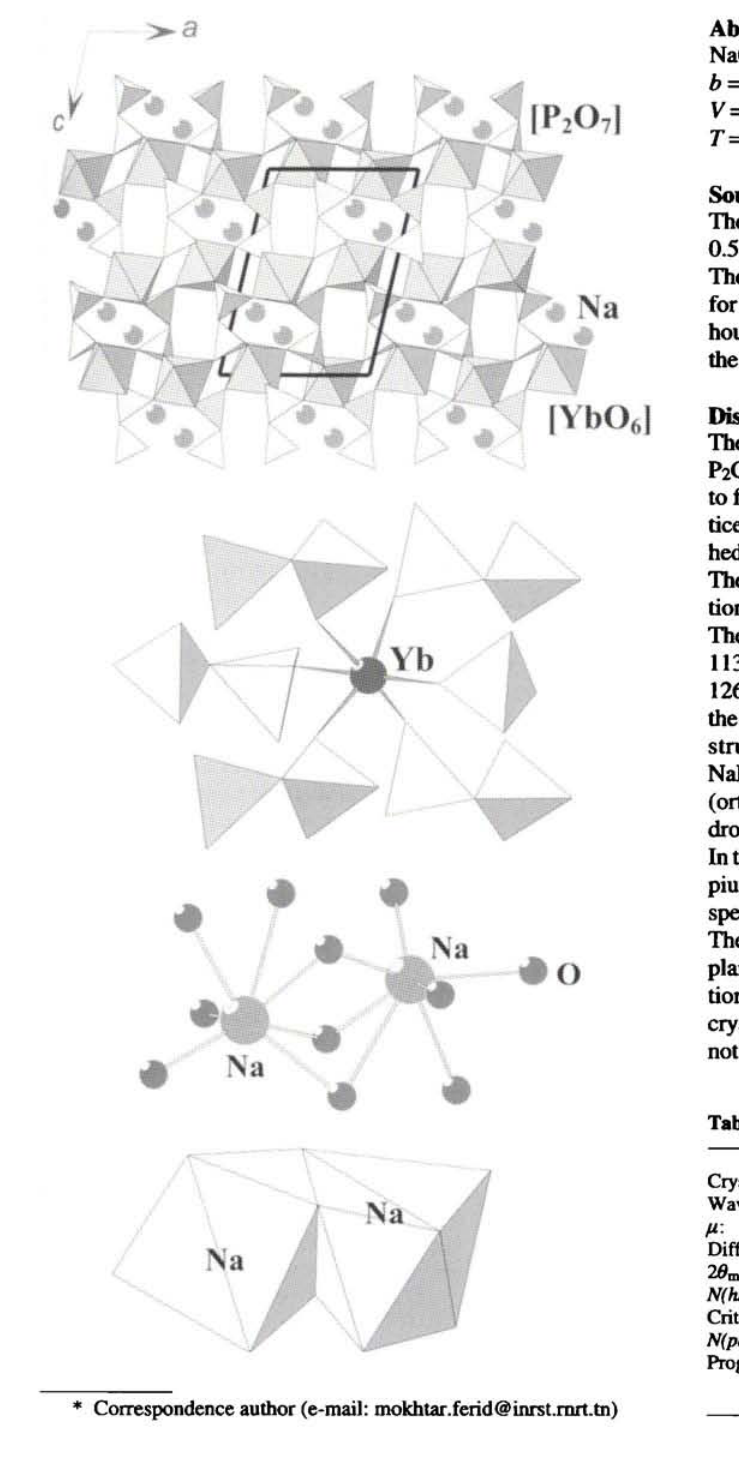
Table 1. Data collection and